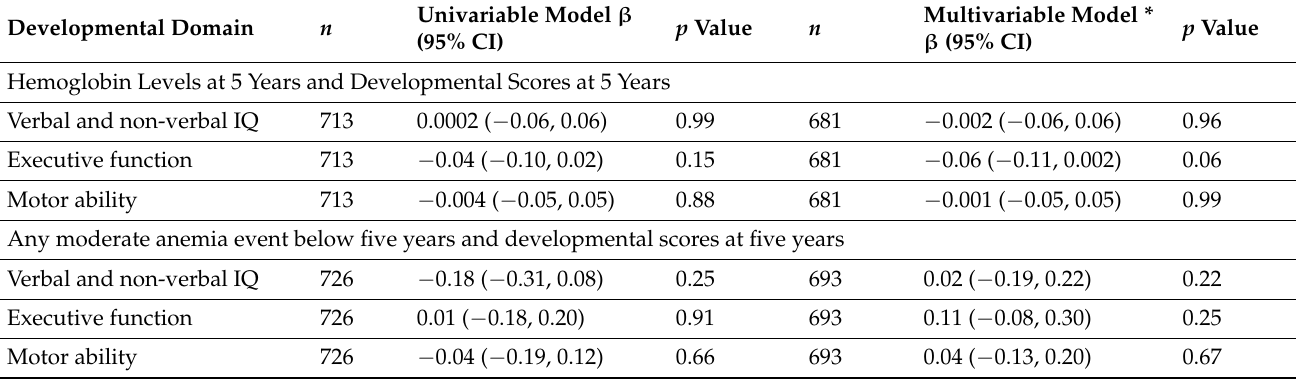
Table 5. Univariable and multivariable linear regression results for the association between hemoglobin levels or anemia and developmental scores at five years.